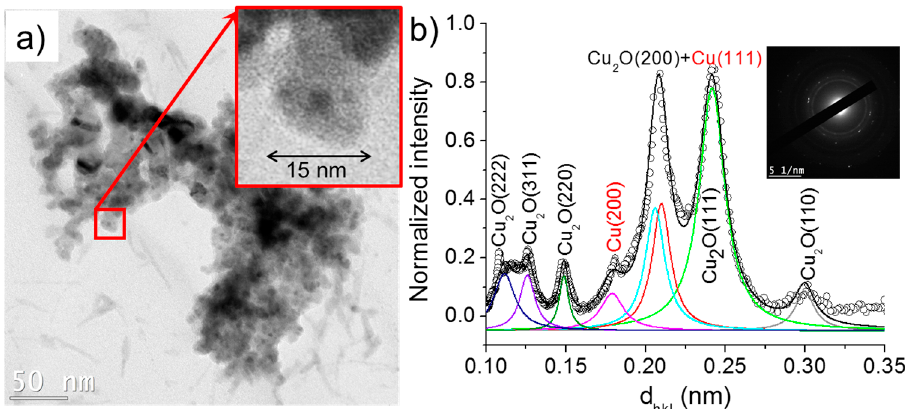
Figure 11. ( a ) TEM images of nanoparticles synthesized the case 2 ( σ 0 = 8 µS/cm) and ( b ) the corresponding SAED pattern (performed on ( a )) radially integrated spectrum. The nanowires identified in case 3 ( σ 0 = 32 µS/cm) had a similar size distribution to those synthesized in solutions of lower conductivities (cases 1 and 2) and were composed of Cu 2 O.